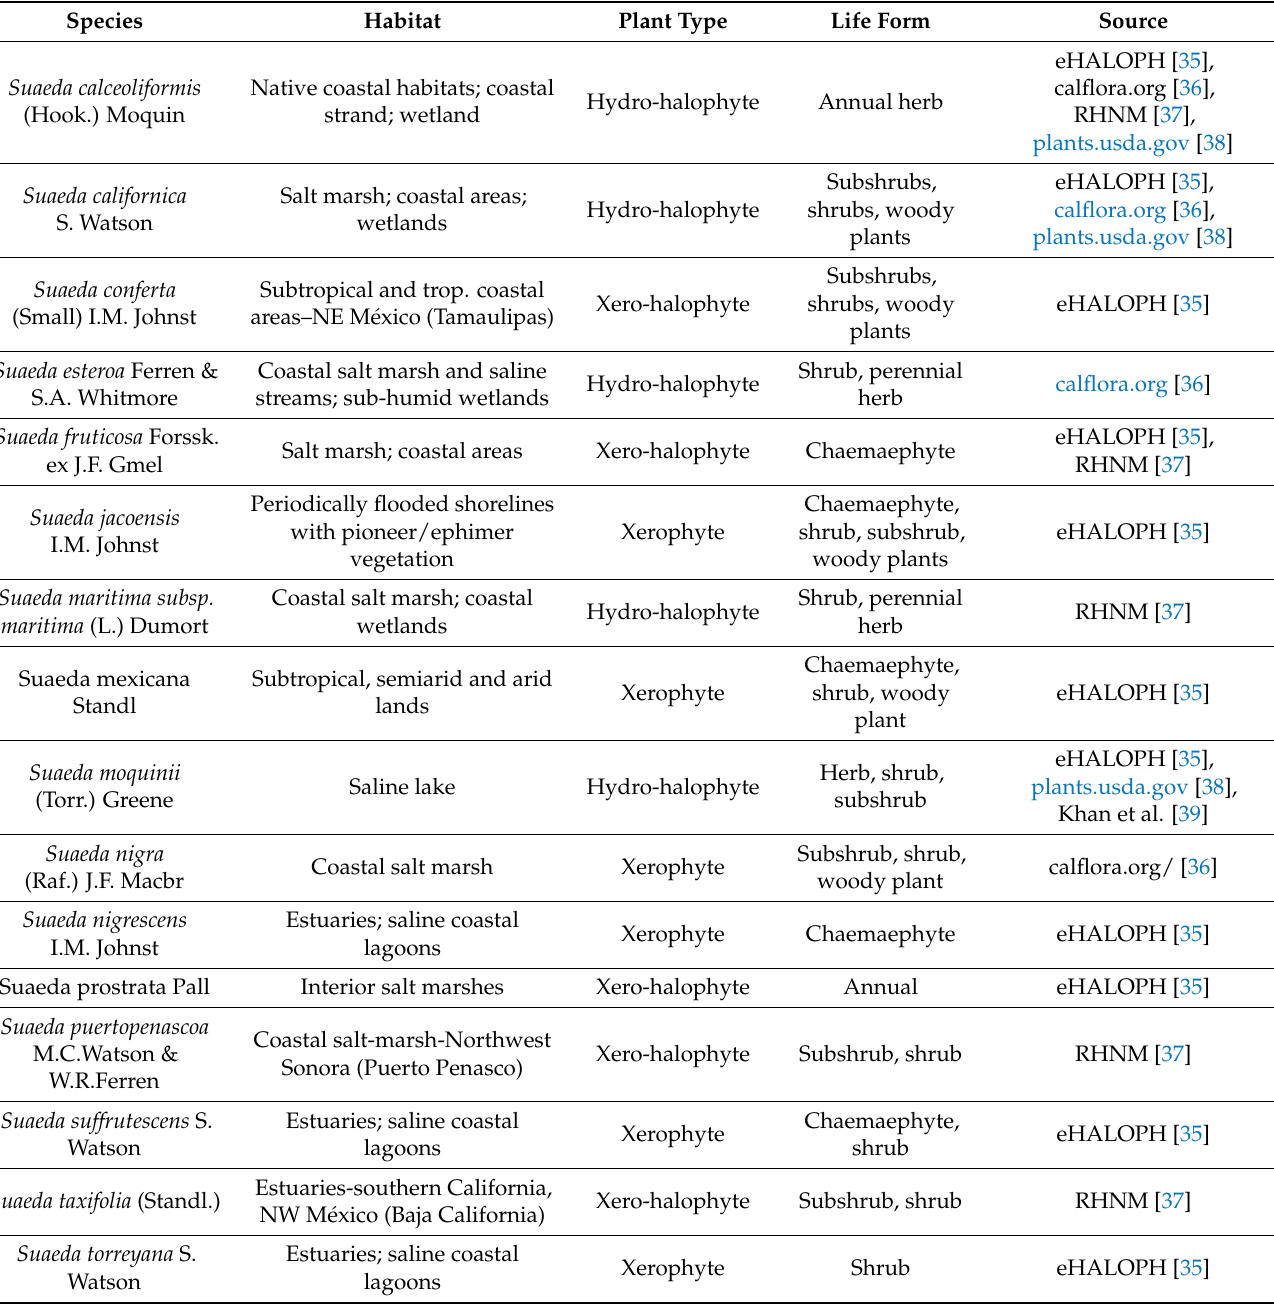
Table 2. Habitat and plant traits of 16 halophytic species from the genus Suaeda spp., Amaranthaceae family, widespread in NW M é xico and SW United